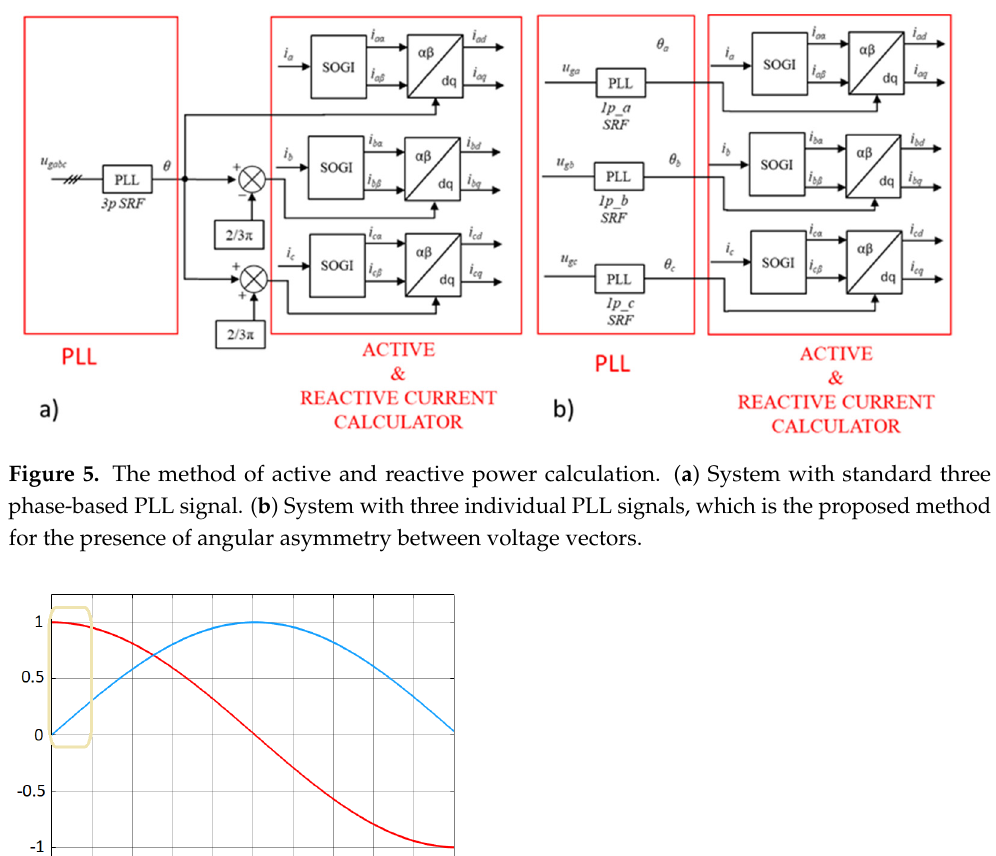
Table 1. The changes of d and q components as a function of the phase angle.